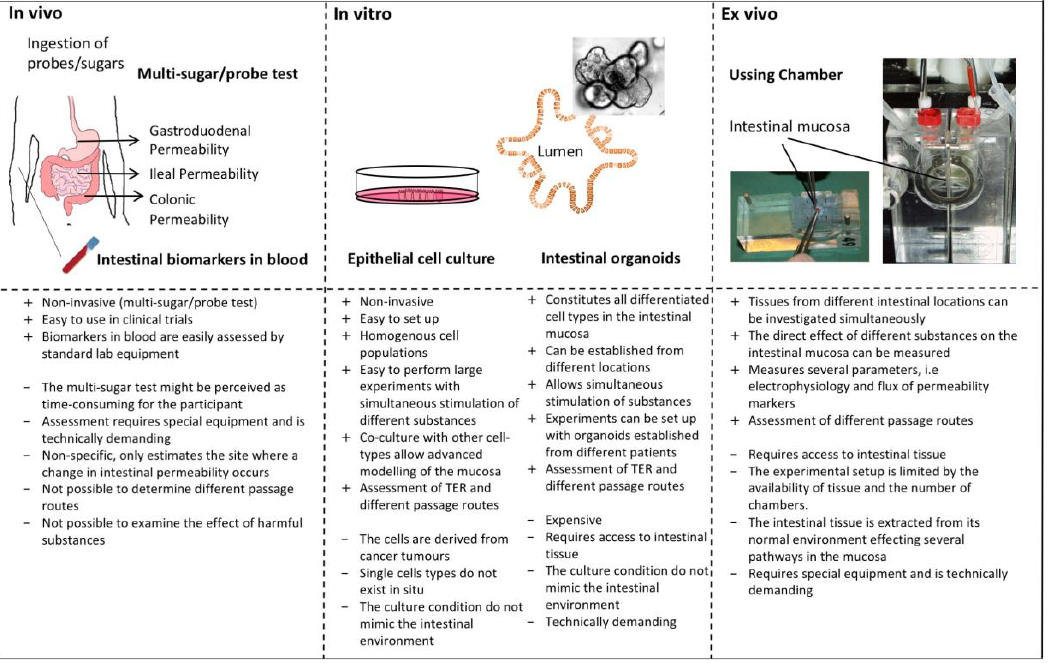
Figure 2. Overview of the different techniques used to measure intestinal barrier function. It is important to consider the aim of the study and the resources in the laboratory prior choosing the methodology. For a thorough assessment of intestinal barrier function the techniques are preferably